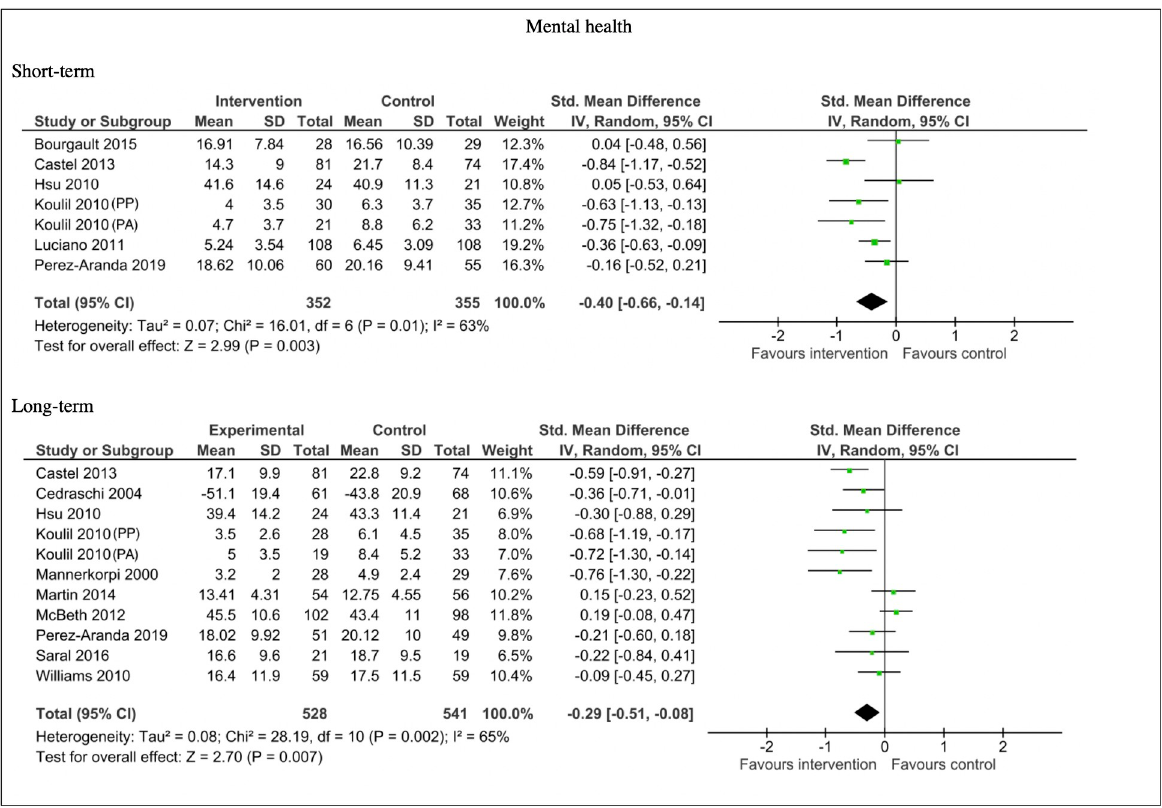
Fig 8. Forest plots of comparisons for mental health measures for intervention compared to waitlist/no treatment/usual care controls.